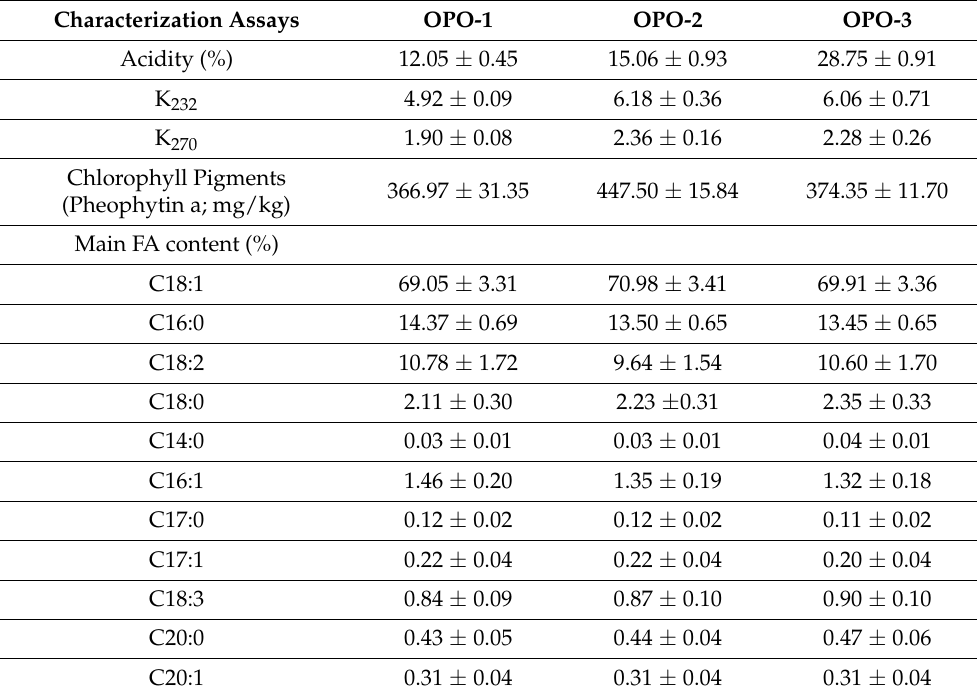
Table 1. Chemical characterization of the crude OPO used (OPO-1, OPO-2, and OPO-3): acidity (% free fatty acids), oxidation products (K 232 and K 270 ), chlorophyll pigments, and fatty acid compo- sition (the average value of three replicates ± standard deviation for each sample is